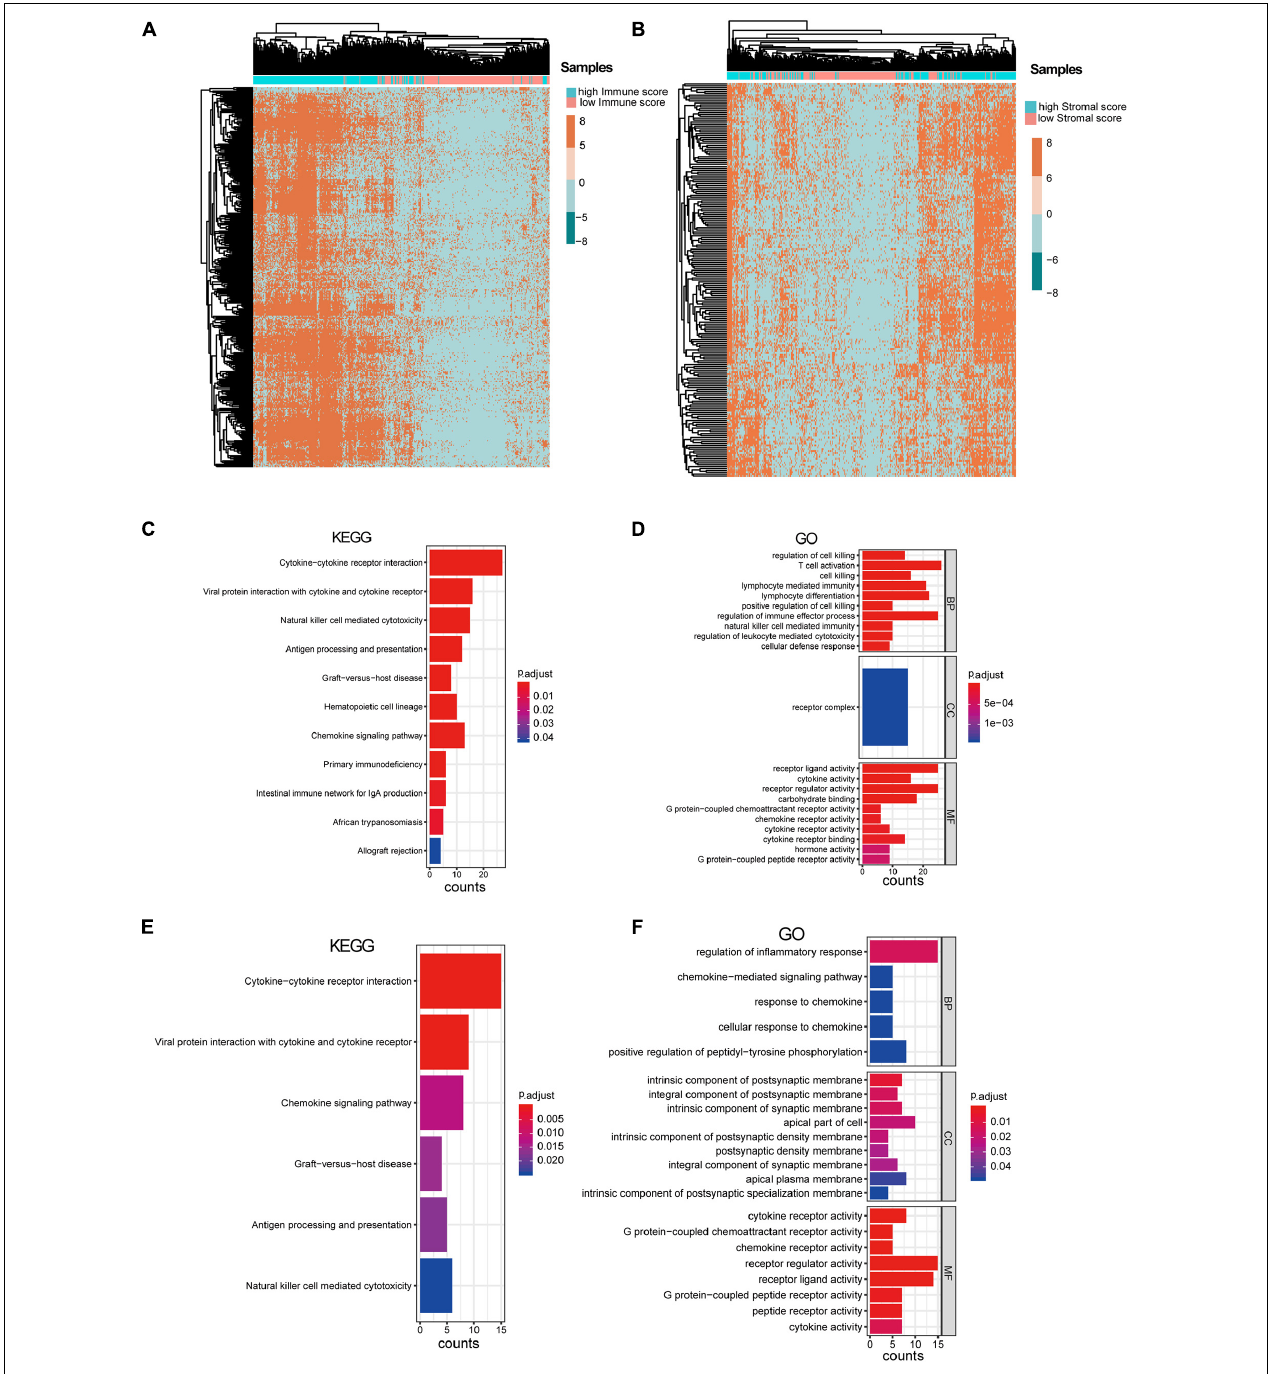
FIGURE 2 | Analysis of immune-associated differentially expressed genes (DEGs) and stromal-associated DEGs. (A) Heat map of immune-associated DEGs in skin cutaneous melanoma (SKCM) samples. (B) Heat map of stromal-associated DEG genes in SKCM samples. It shows that only immune-associated DEGs could nicely separate the low- vs. high-immune-score samples. (C,D) Enrichment analysis of the immune-associated DEGs. (E,F) Enrichment analysis of the stromal-associated